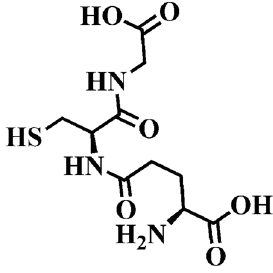
Figure 16: Molecular structure of GSH ( reduced ) [ 250 ]